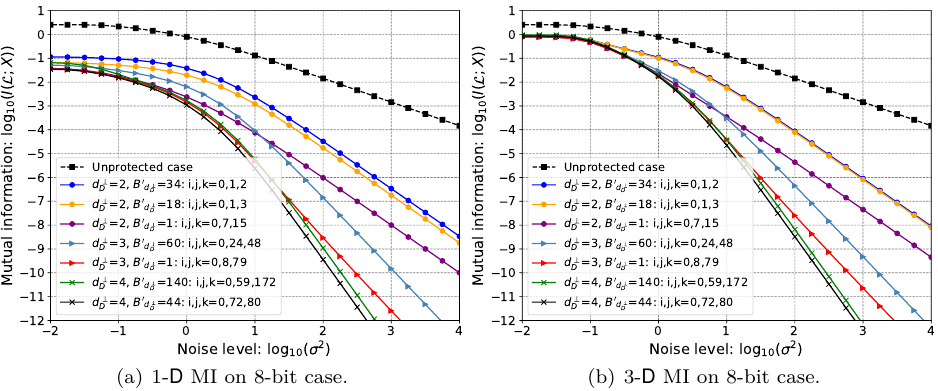
Figure 3: An information-theoretic evaluation of the leakages L and the sensitive variable X in (3 , 1)-SSS based masking. We choose seven codes with different values of d ⊥ . The three public points are α B 0 d ⊥ D